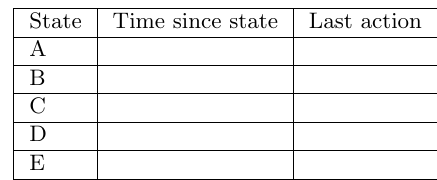
Table 2: Memory table.